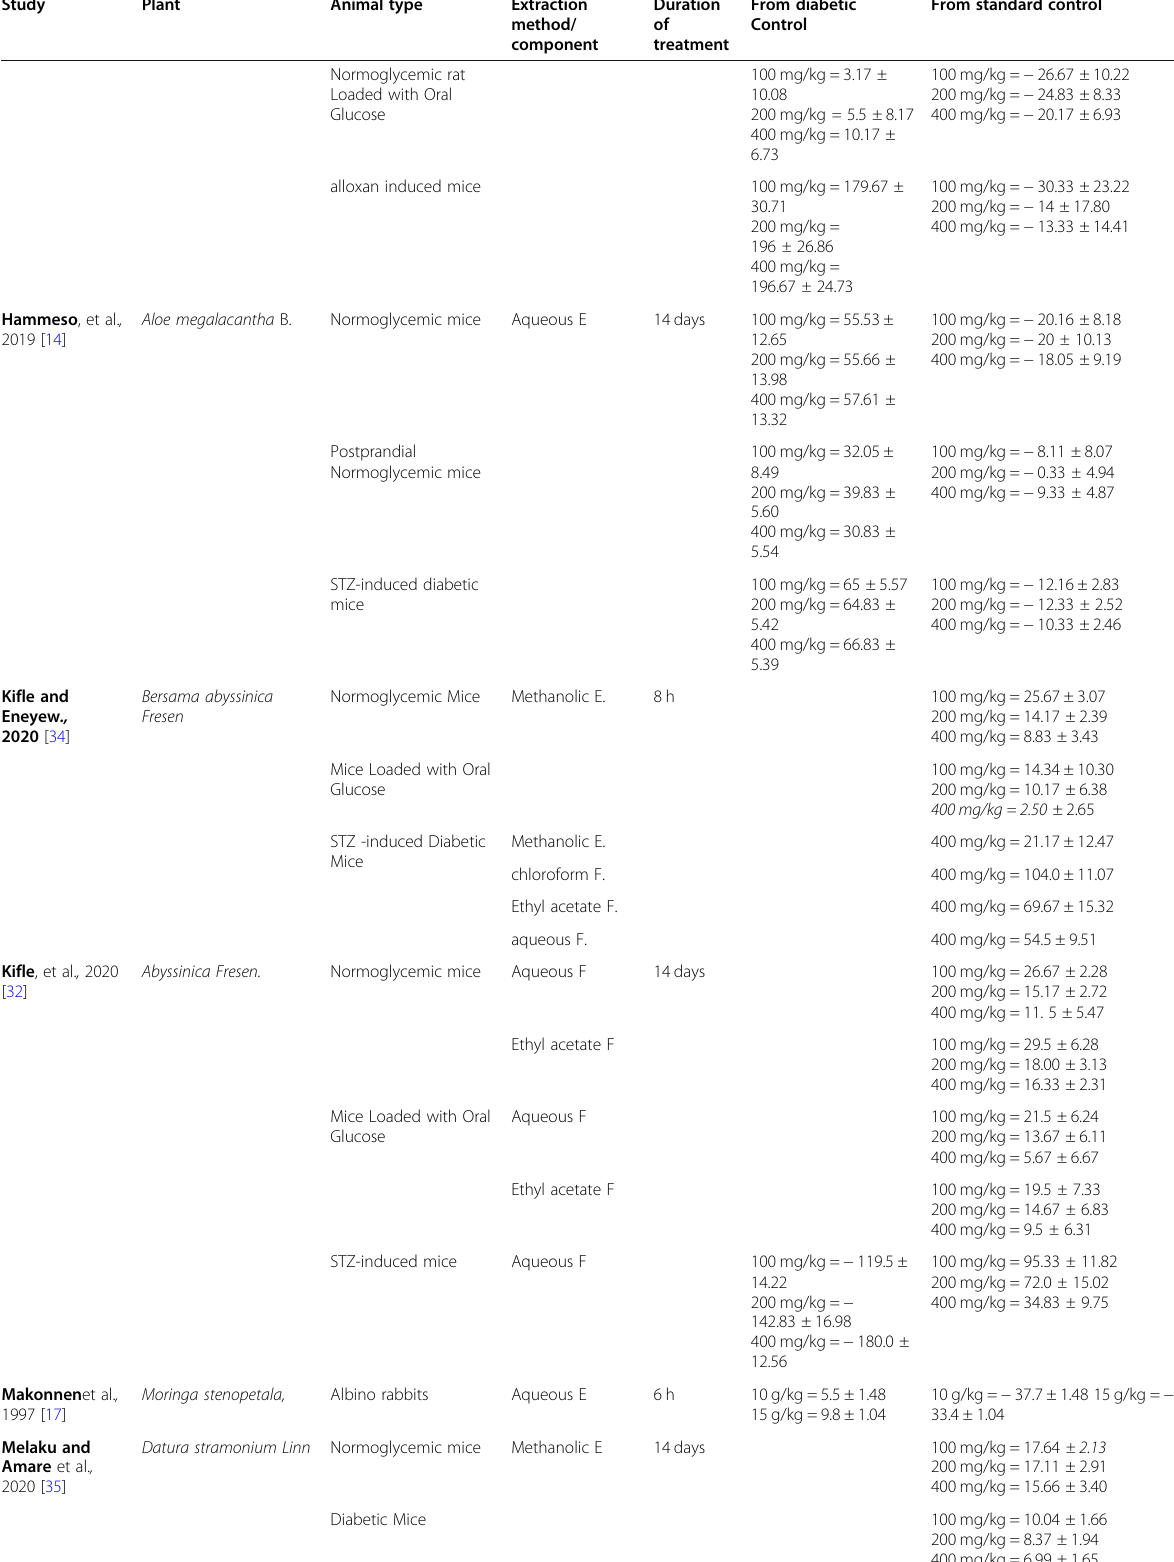
Table 3 In vivo anti-diabetic activity of medicinal plat in Ethiopia (Continued)